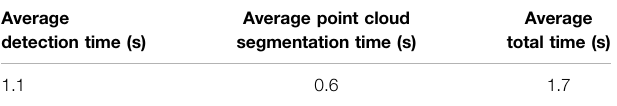
TABLE 2 | Algorithm time ef fi